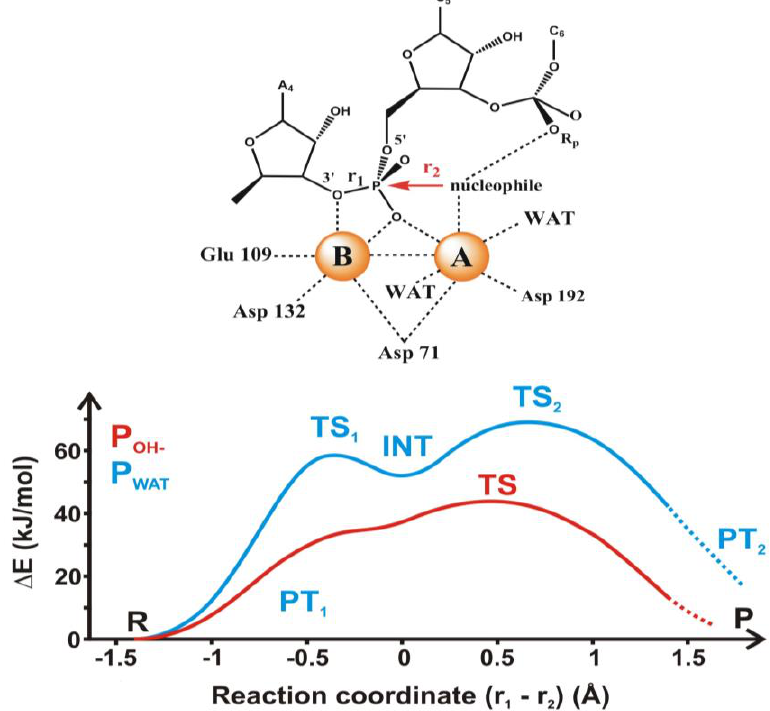
Figure 8. Two possible reaction routes for the hydrolysis of ribonuclease H. Top: schematic structure of the active site, bottom: blue line: attack by a water molecule, red line: attack by a hydroxyl group (figure drawn on the basis of Figure 3 of Ref.